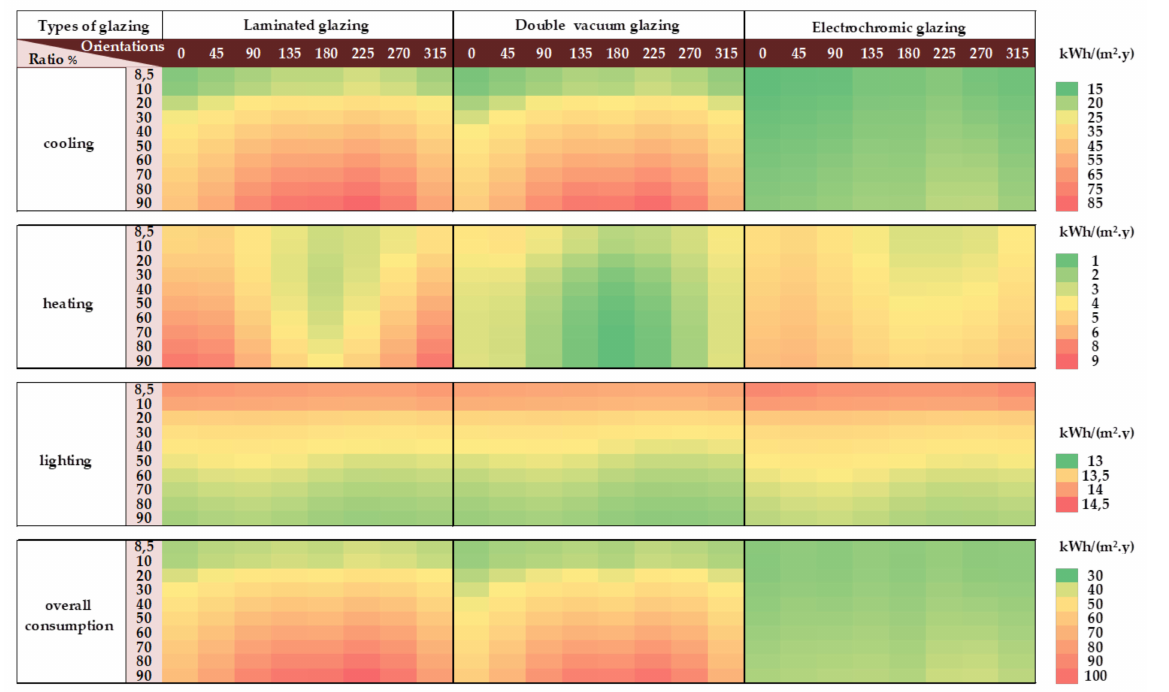
Figure 4. Energy consumption as a function of WWR, glazing window, and orientation for Cooling. Heating. Lighting. Overall consumption.